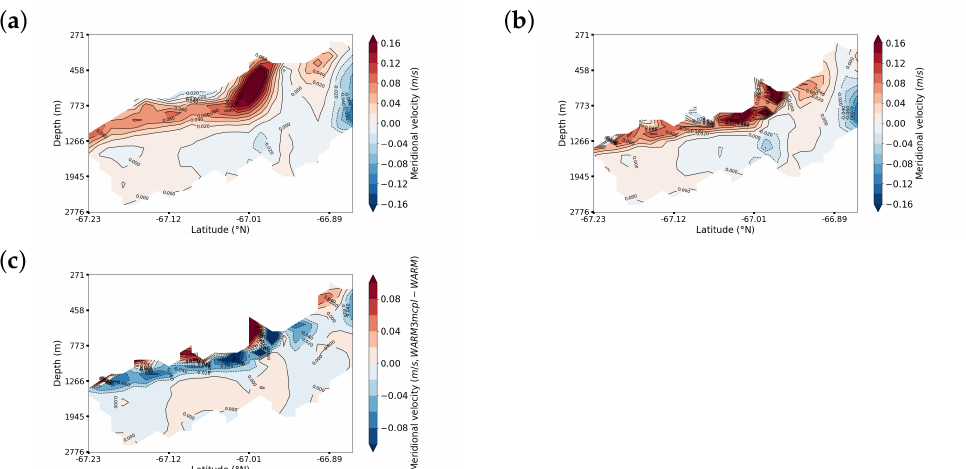
Figure A7. Cross-sections in the TIS cavity of ocean meridional current speed for WARM3mcpl ( a ) and WARM ( b ), and of ocean meridional current speed difference between WARM3mcpl and WARM ( c ). All averaged over the 20-year simulations.